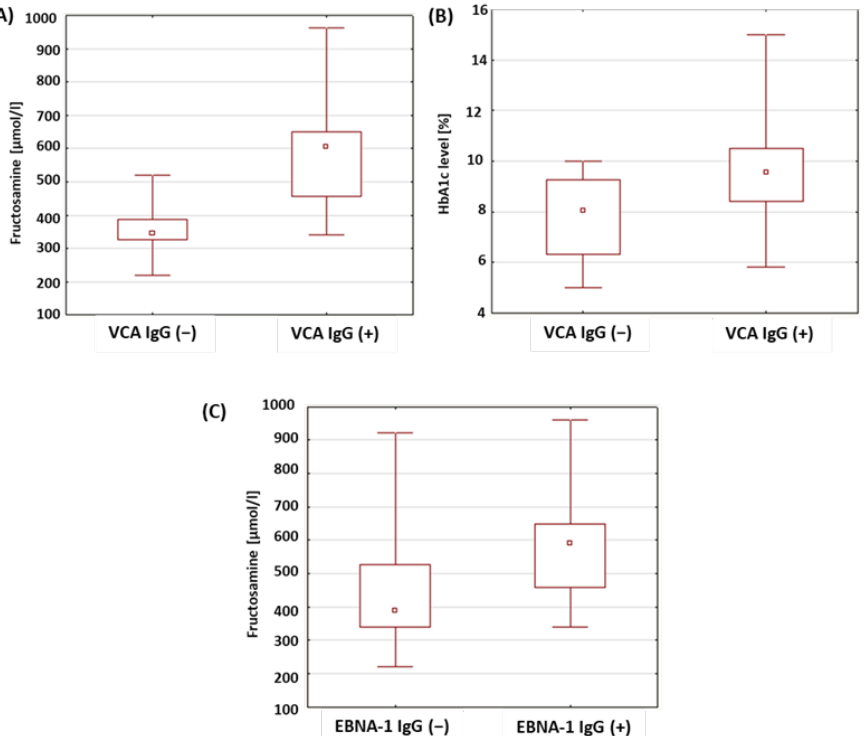
Figure 7. Evaluation of selected parameters of carbohydrate balance in patients with type 1 diabetes in relation to the presence of antibodies against antigens of the EBV virus. ( A ) Comparison of fructosamine concentrations in a group of patients with type 1 diabetes in relation to the presence of anti-VCA antibodies in the IgG class; ( B ) comparison of the levels of HbA1c in a group of patients with type 1 diabetes in relation to the presence of anti-VCA antibodies in the IgG class; ( C ) comparison of fructosamine concentrations in a group of patients with type 1 diabetes in relation to the presence of anti-EBNA-1 antibodies in the IgG class.